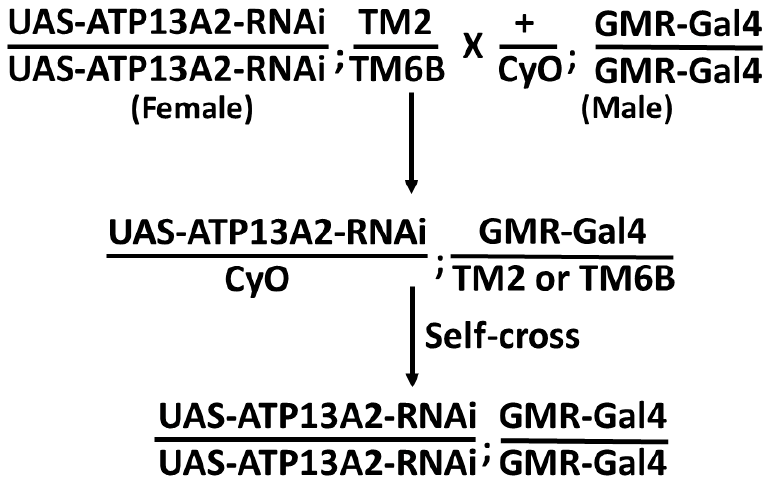
Figure 1. Schematic representation of the UAS-Gal4 system to generate flies silencing ATP13A2 under control of eye-specific driver GMR-Gal4. Virgin female flies are crossed with male flies to obtain the progeny. CyO, TM2 and TM6B are the balancer chromosome used to follow the target genes expression.